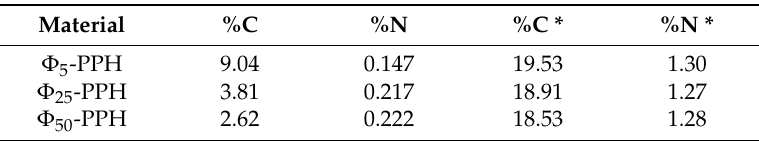
Table 1. Chemical composition of Φ -PPH material.